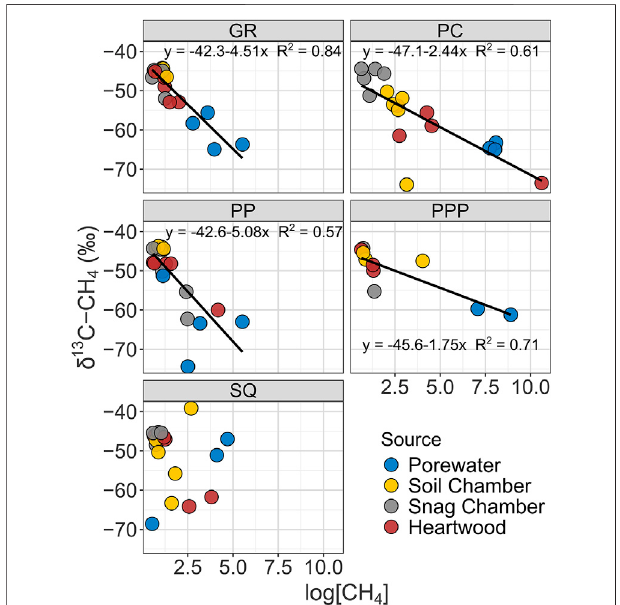
FIGURE 3 | Linear regressions showing relationship between δ 13 C-CH 4 stable isotopic values with CH 4 concentrations from various sources by study sites. Note all CH 4 concentrations were log